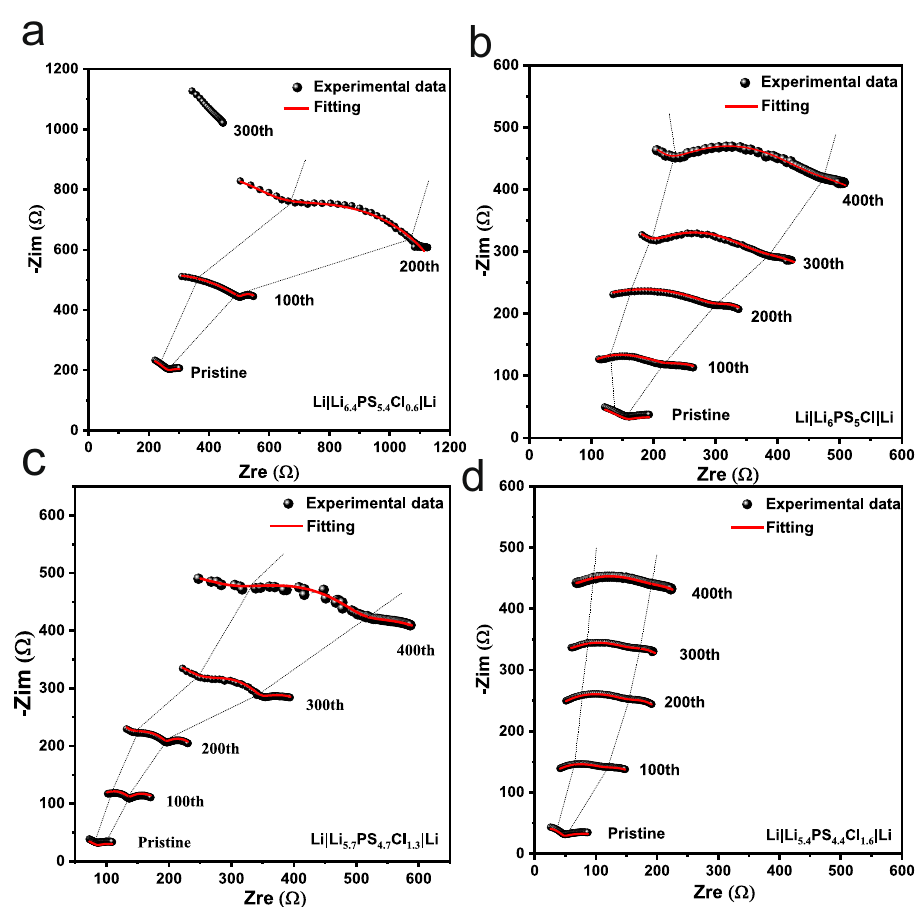
Fig. 4 Interfacial evolution of the Li||Li cells subjected to Li plating/stripping (Fig. 3). The impedance spectra were acquired for every 100 cycles from the in situ EIS measurements on the cells using Cl-06 ( a ), Cl-10 ( b ), Cl-13 ( c ), and Cl-16 ( d )